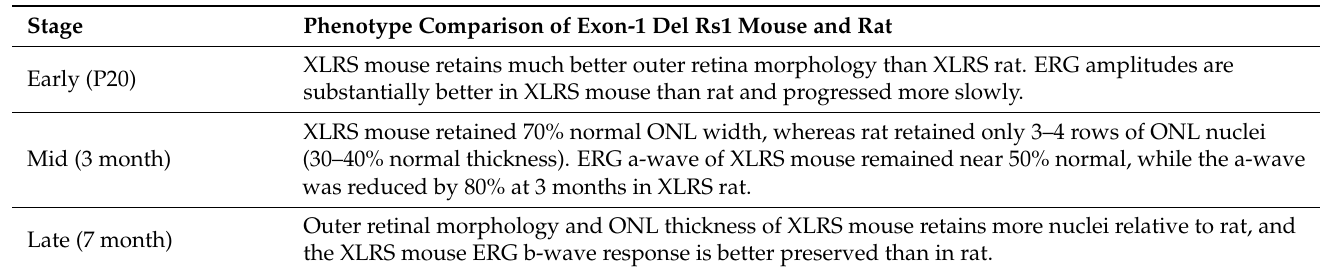
Table 2. Difference in onset and progression of exon-1 del Rs1 mouse and